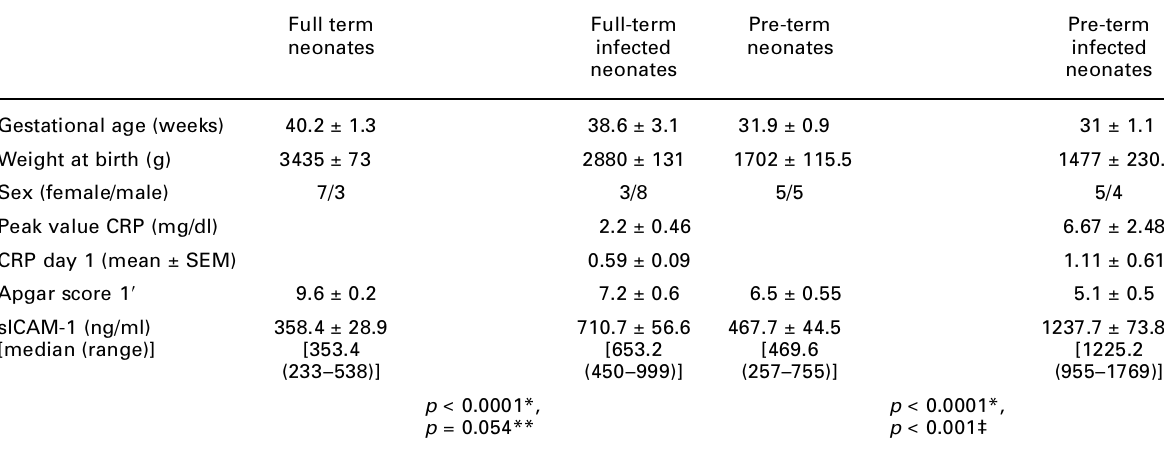
Table 1. Clinical and laboratory characteristics of the study groups Full term